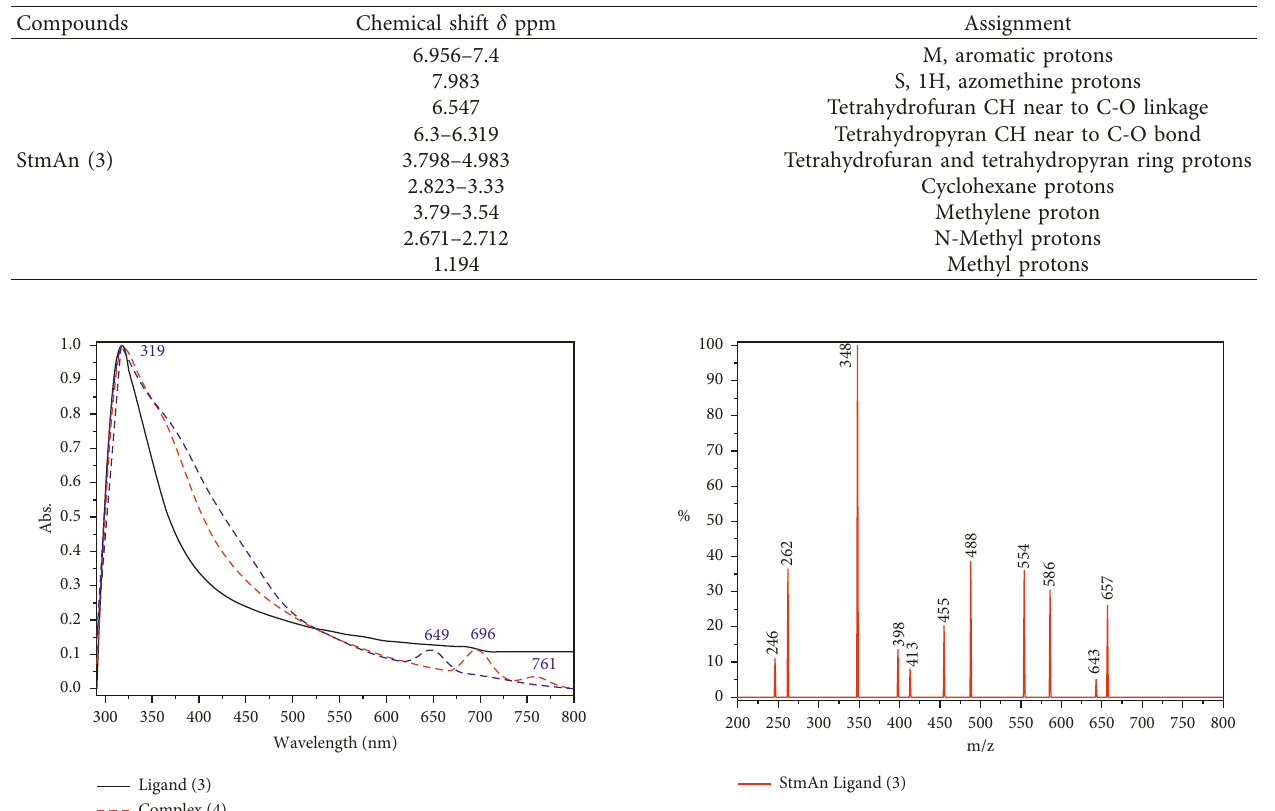
Table 1: 1 H NMR spectral data of StmAn ligand (3) .